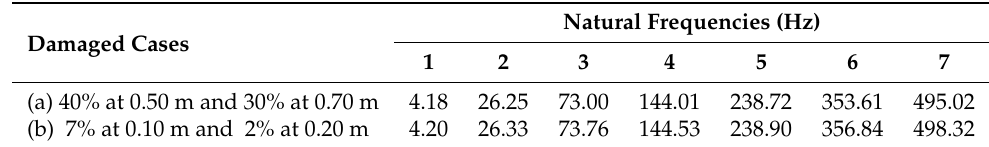
Table 4. Numerically computed natural frequencies of double damage cases (a) and (b) with parameters of position and severity.